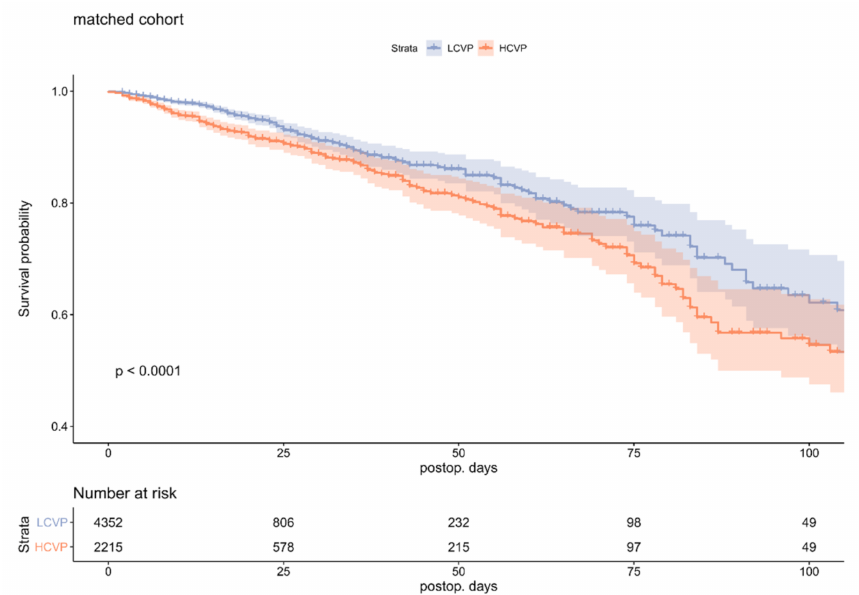
Figure 2. In-hospital survival probability over time, matched cohort. LCVP = Low central venous pres-